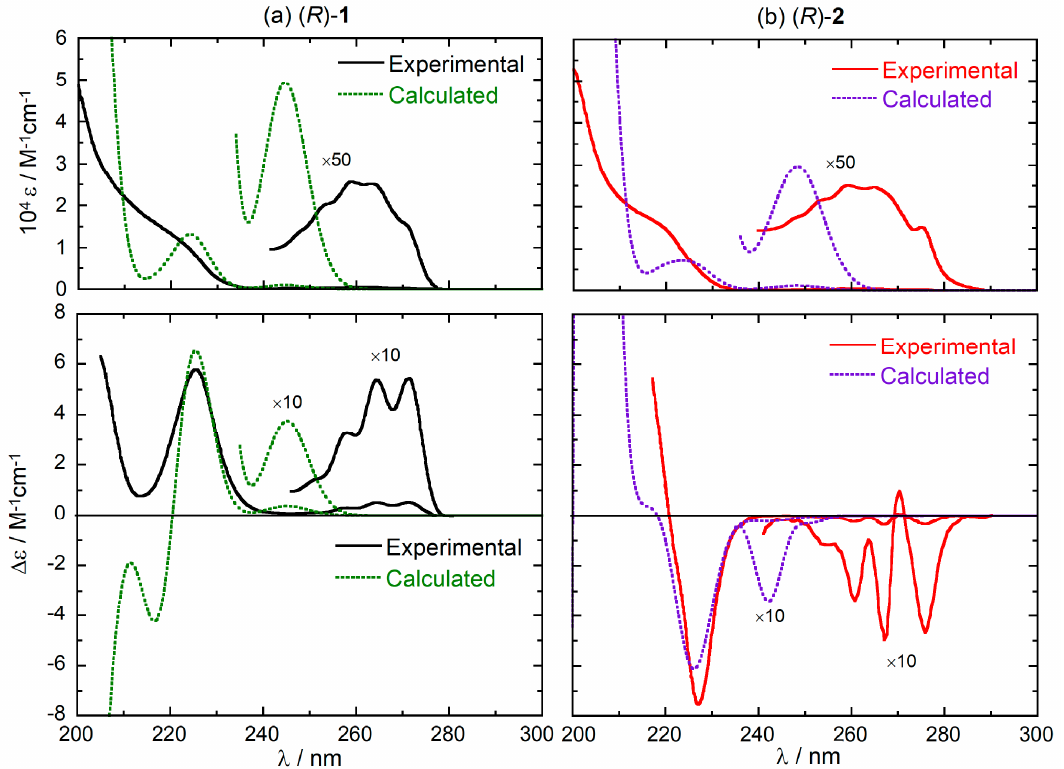
Figure 3. Comparison between the experimental and weighted-average calculated UV ( top ) and ECD ( bottom ) spectra of ( R )- 1 (panel a ) and ( R )- 2 (panel b ). Calculated spectra plotted as sums of Gaussians with 0.15 eV exponential band-width, shifted by +15 nm and scaled for better comparison. Experimental spectra reproduced from Ref. [28] with permission of Taylor & Francis Ltd., www.tandfonline.com.